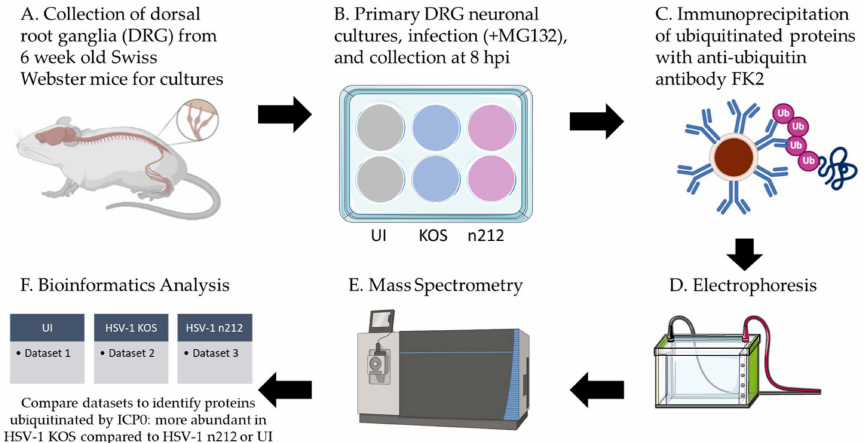
Figure 2. Schematic representation of the sample preparation for LC-MS/MS. ( A ) Primary adult dorsal root ganglion (DRG) neurons were resected from 6 wk old Swiss Webster mice and cultured at a minimum of 40,000 neurons per well. Two wells per condition were analyzed during each of two experiments. ( B ) DRG neurons were treated with MG132 and infected with HSV-1 KOS or HSV-1 n 212 (30 MOI), or left uninfected (UI) for 8 h. ( C ) Equal amounts of total DRG protein were mixed with FK2 antibodies covalently bound to magnetic Dynabeads to immunoprecipitate ubiquitinated proteins from each sample. Proteins were eluted from beads. ( D ) Protein eluate was separated on a 10% SDS-PAGE gel, excised into 10 equal size bands, and digested in-gel with trypsin. ( E ) Peptides were analyzed by nano LC-MS/MS. ( F ) Data were analyzed and